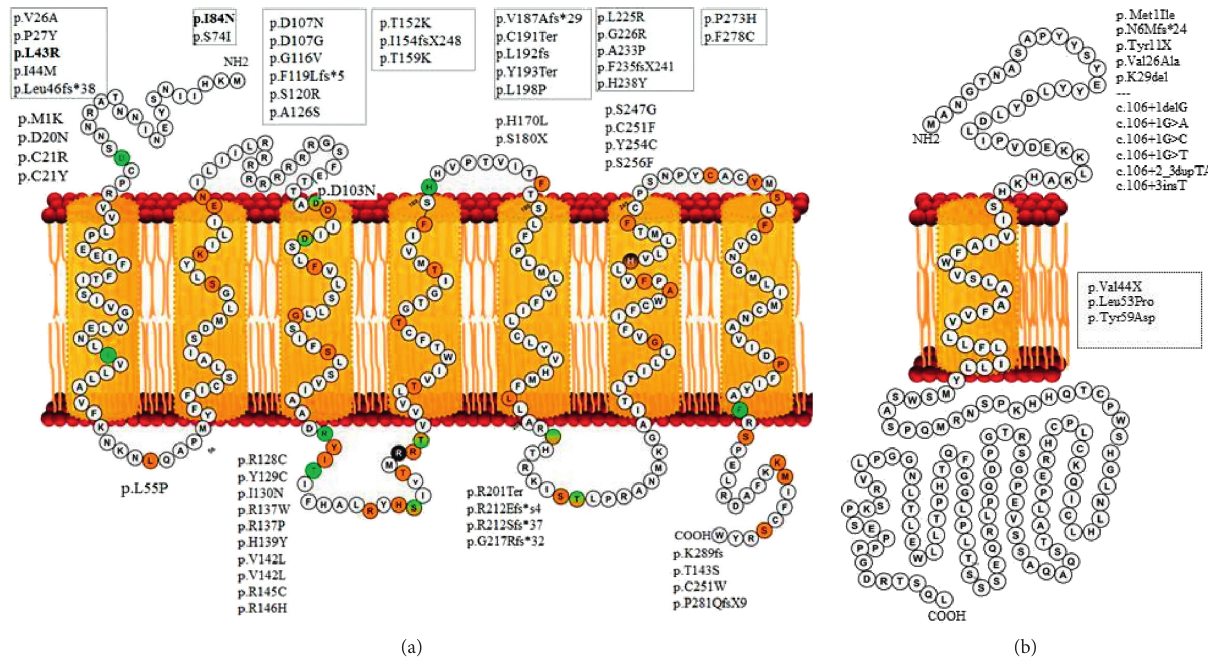
Figure 4: (a) MC2R receptor has 297 amino acids and consists of 7 transmembrane domains from positions 24–49 (TM helix 1, 26–52),